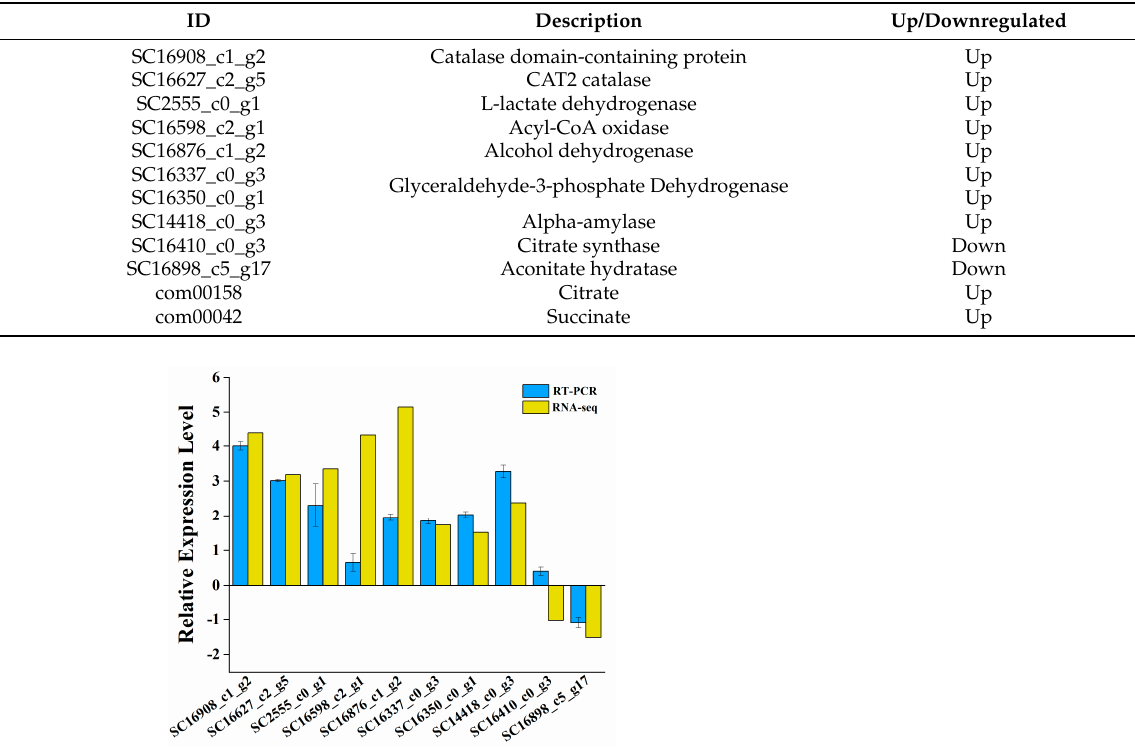
Figure 6. Real − time quantitative PCR detection of the key resistance regulatory genes between the SCs and YL in Aureobasidium pullulans NG. At least three independent experiments were performed in all the experiments. The data represent the average of biological replicates with standard